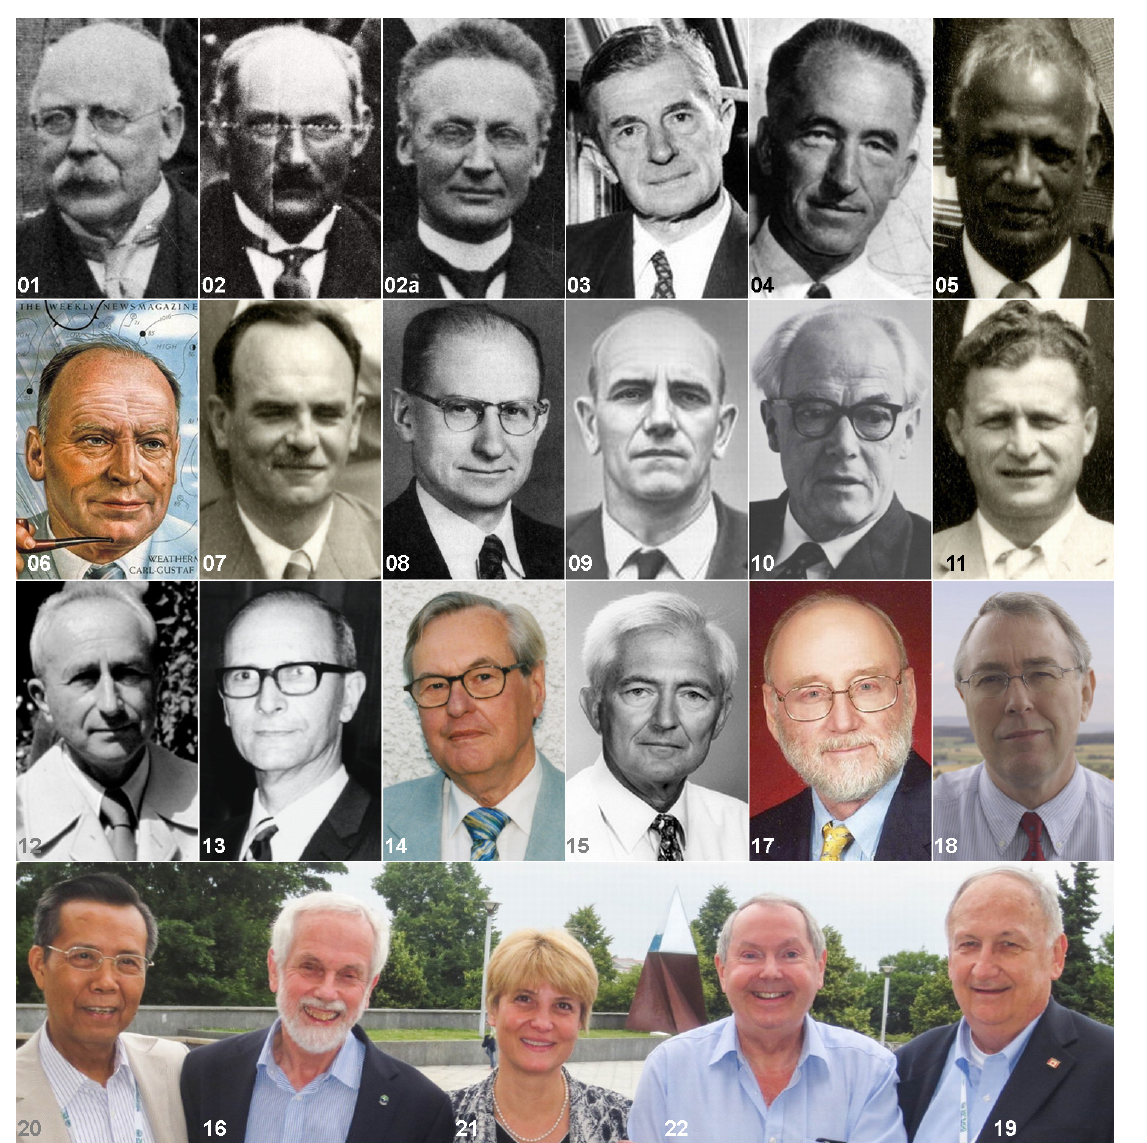
Figure 3. Collection of portraits of the 23 IAMAS presidents serving from 1919 to 2019: (01) Napier Shaw, (02) Axel Wallén, (02a) Vil- helm Bjerknes (acting president after Wallén’s death in 1935), (03) Sidney Chapman, (04) Jacob Bjerknes, (05) Kalpathi Ramanathan, (06) Carl-Gustaf Rossby, (07) Jacques van Miehgem, (08) Horace Byers, (09) Alexander Obukhov, (10) Reginald Sutcliffe, (11) Sig- mund Fritz, (12) Christian Junge, (13) Warren Godson, (14) Hans-Jürgen Bolle, (15) Brian Tucker, (16) Brian Hoskins, (17) Robert Duce, (18) Huw Davies, (19) Michael MacCracken, (20) Guoxiong Wu, (21) Athéna Coustenis and (22) John Turner. See Table 2 for detailed information. Photo credits: the bottom row depicts five presidents (no. 16 , 19–22 ) together at IUGG-2015 in Prague (positions not in chrono- logical order), © Maggie Turner; for 06 , © Time Magazine, vol. 68, no. 25, 17 December 1956; no. 01 , 02 and 02a , cuttings from Fig. 2; no. 05 , 07 and 11 , cuttings from group photograph of 1959 (© B. J. Harris; Ohring et al., 2009); no. 3 and 13 from Bojkov, 2012; and other portraits from web